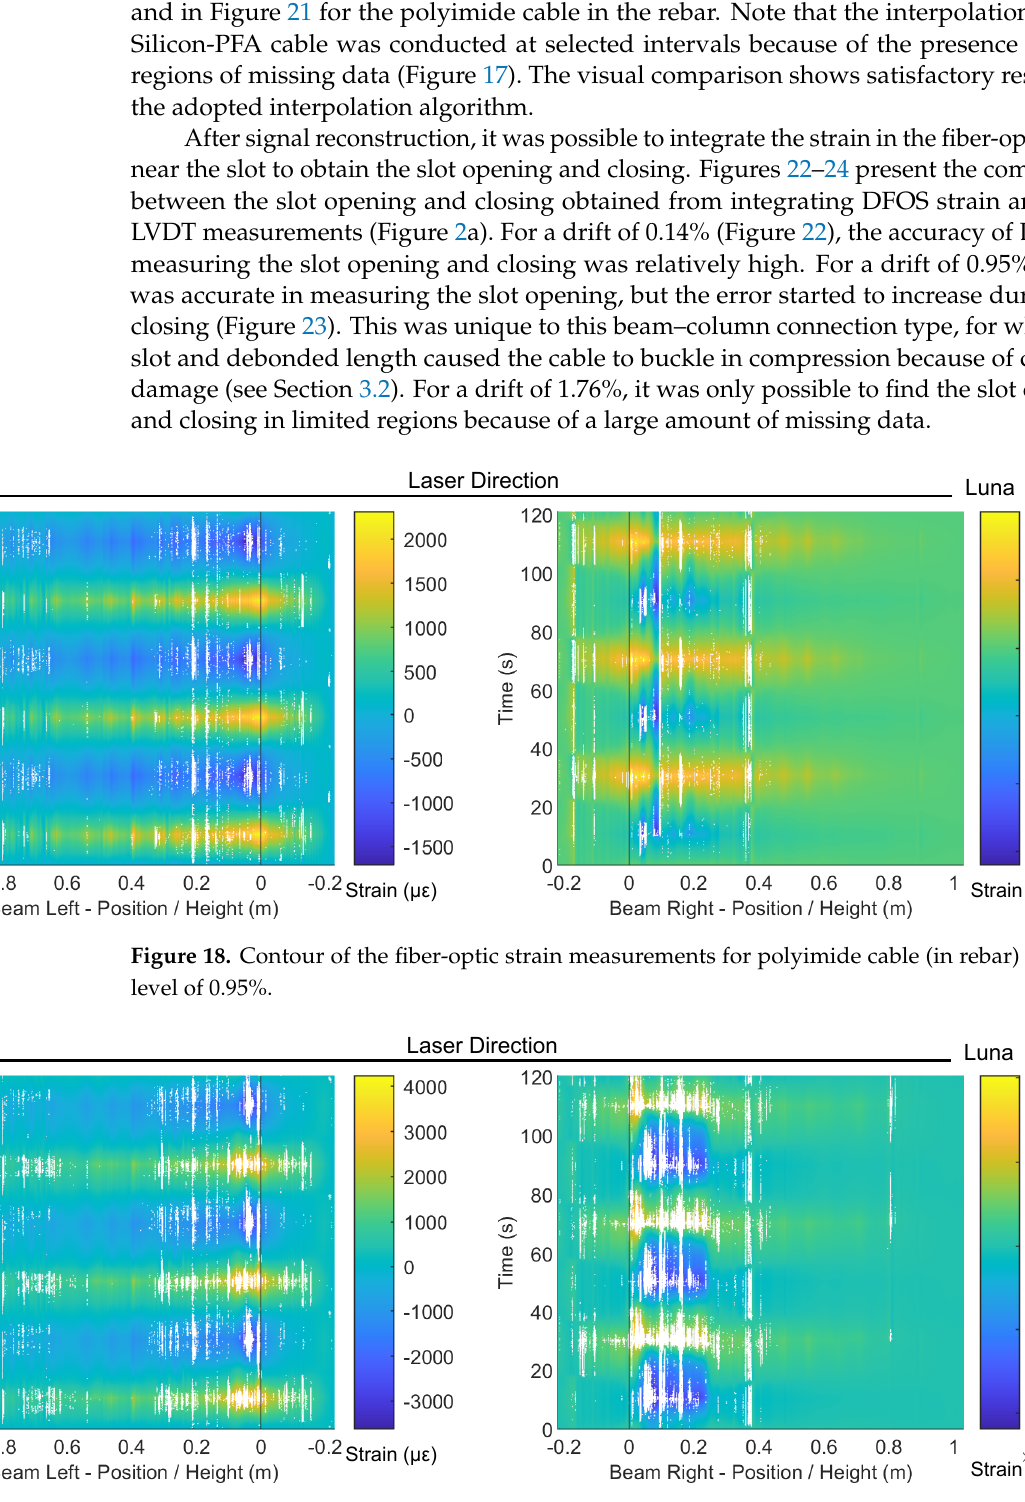
Figure 19. Contour of the fiber-optic strain measurements for polyimide cable (in rebar) at a drift level of